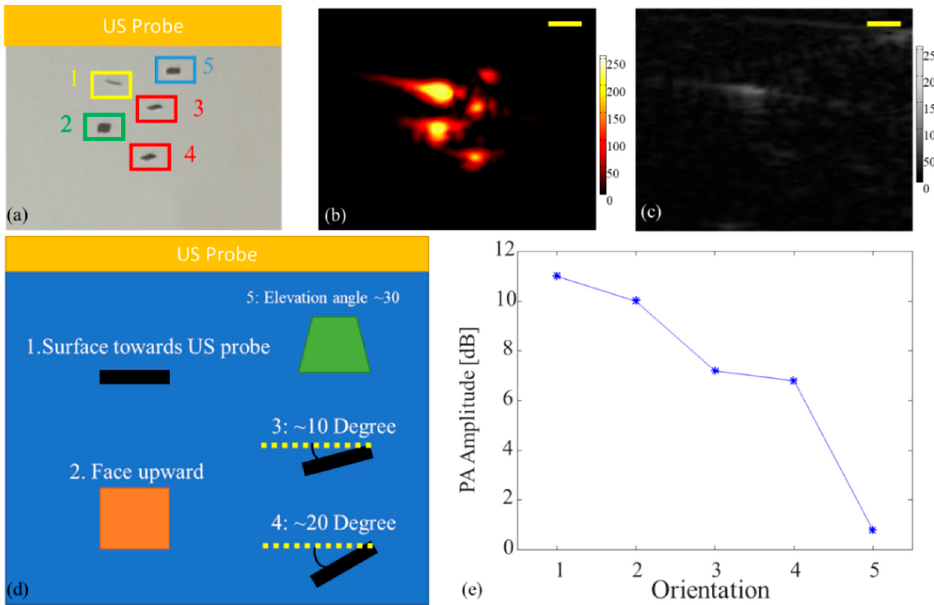
Figure 4. Imaging results for detecting microrobots in different orientations ( a ) Reference photograph, object “1” is parallel, and object “2” is perpendicular to the US probe surface; ( b ) PA imaging visualizes all five objects. ( c ) US imaging only detected object “1”. ( d ) Schematic of the orientation of microrobots. ( e ) Variation of PA signal amplitude at different orientations. The scale bars are 1 mm.